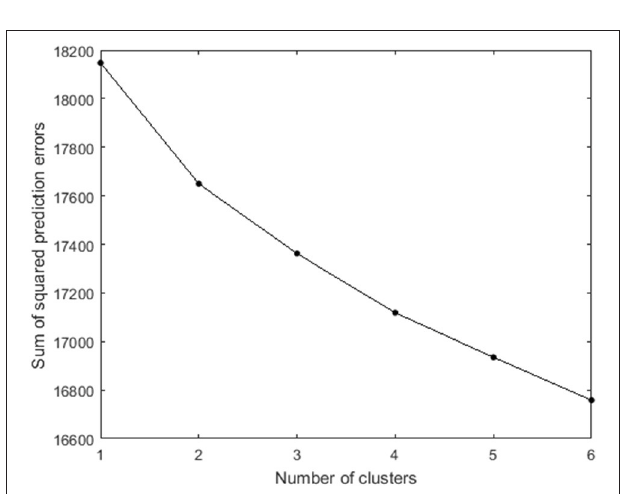
FIGURE 7 | Scree plot of the number of clusters vs. the sum of squared prediction errors for the 28 selected participants from the COGITO study. Note that the y -axis does not start at